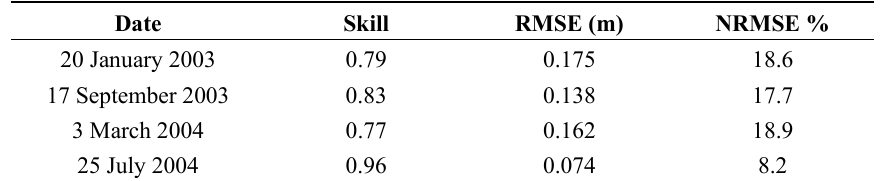
Table 4. Quantitative assessment of synoptic simulations during the four time periods corresponding to the Radarsat scenes at the Apalachicola tide gage